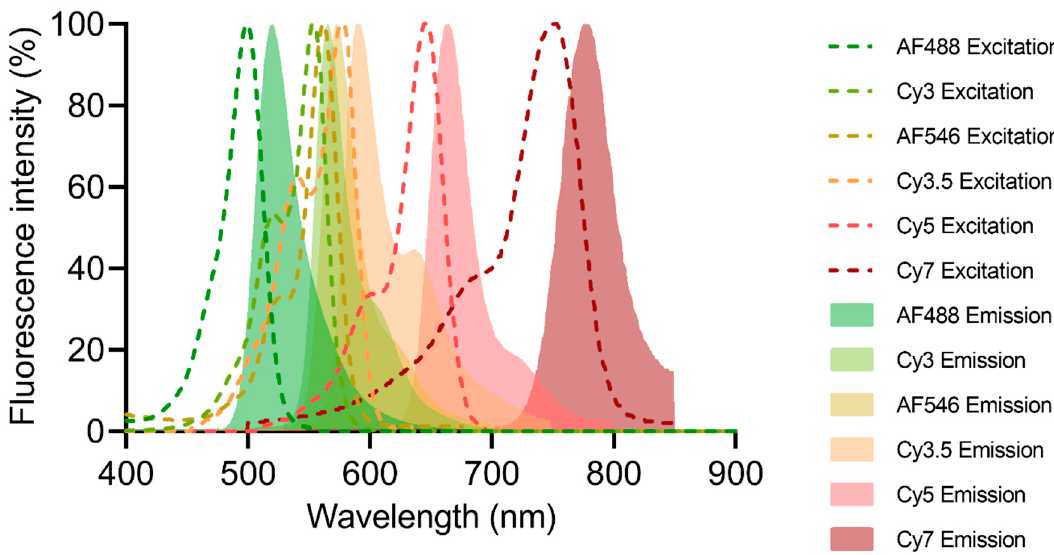
Figure 2. Fluorescence spectra of cyanine and Alexa Fluor dyes.